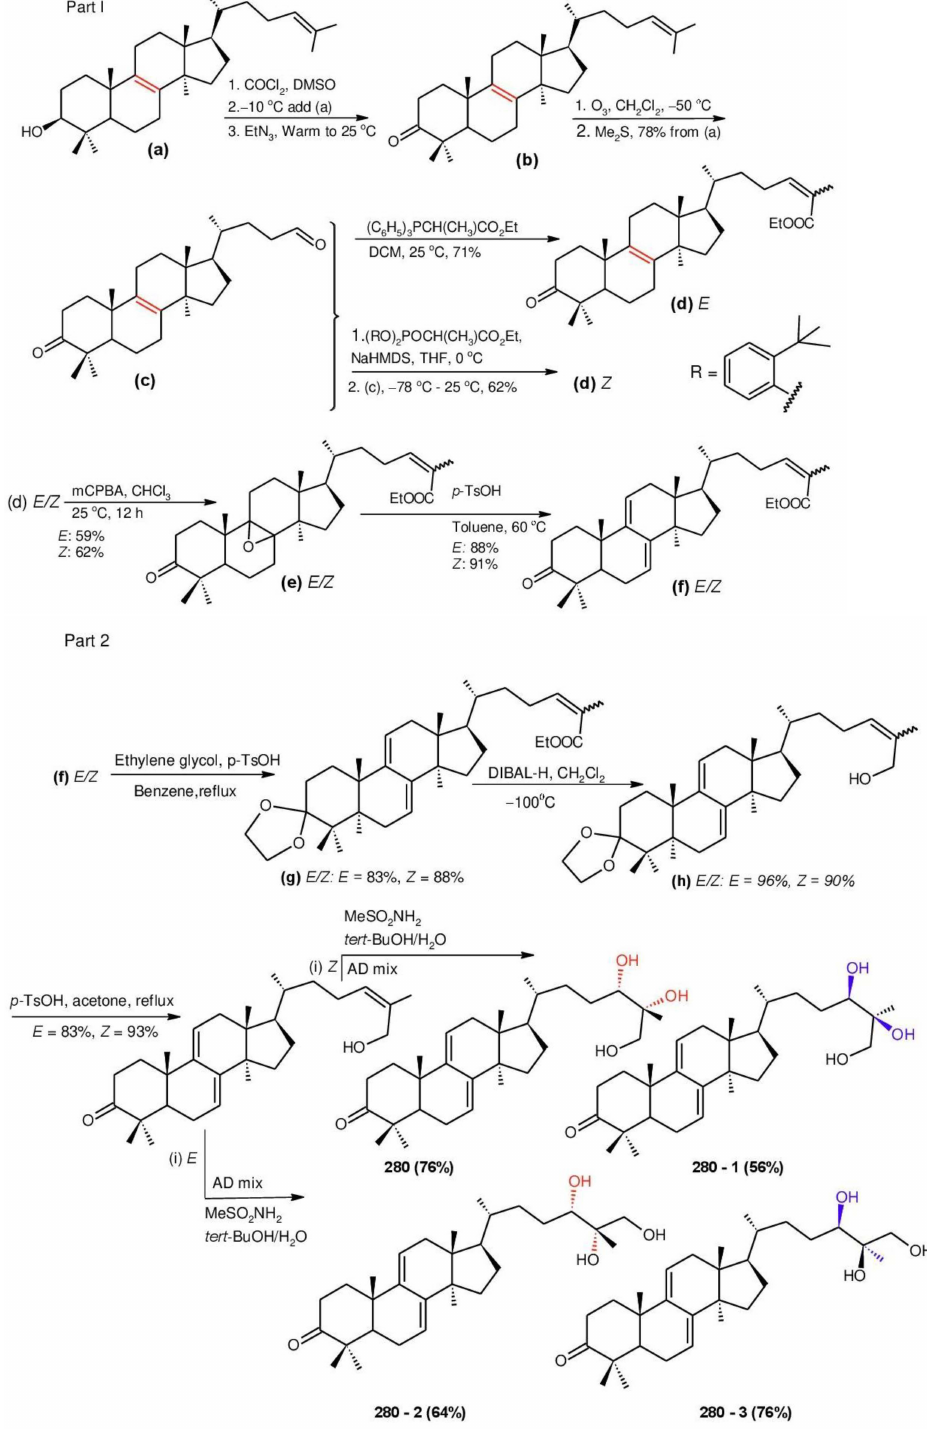
Figure 9. 7(8),9(11)-diene-triterpenoids: semi-synthesis of ganodermantriol ( 291 ) and its stereoiso- meric